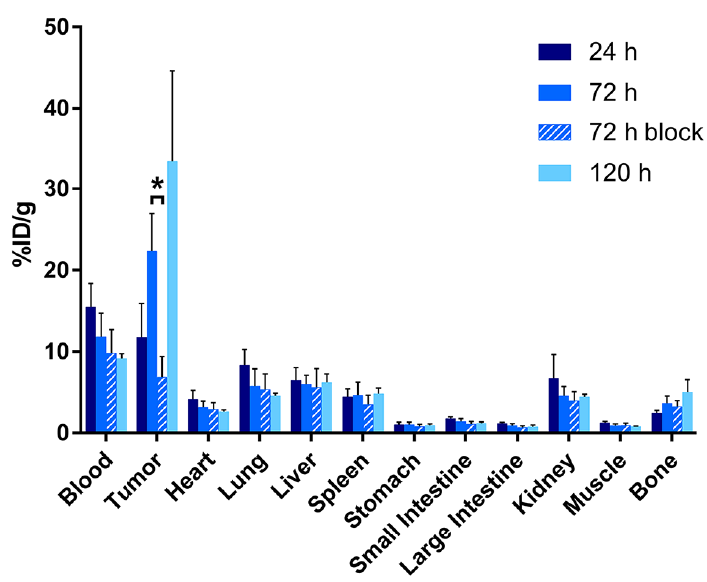
Figure 3. Biodistribution data from athymic nude mice (n = 5 per time point) bearing SKOV3 human ovarian cancer xenografts collected 24, 72, and 120 h after the intravenous administration of [ 89 Zr]Zr-DFO-AR20.5 (0.65–0.69 MBq; 6.6–7.0 µ g, in 200 µ L 0.9% sterile saline). For the 72 h blocking experiment, the mice were administered the same dose of [ 89 Zr]Zr-DFO-AR20.5 mixed with an excess of unmodified AR20.5 (~500 μg per mouse). *p = 0.0006.